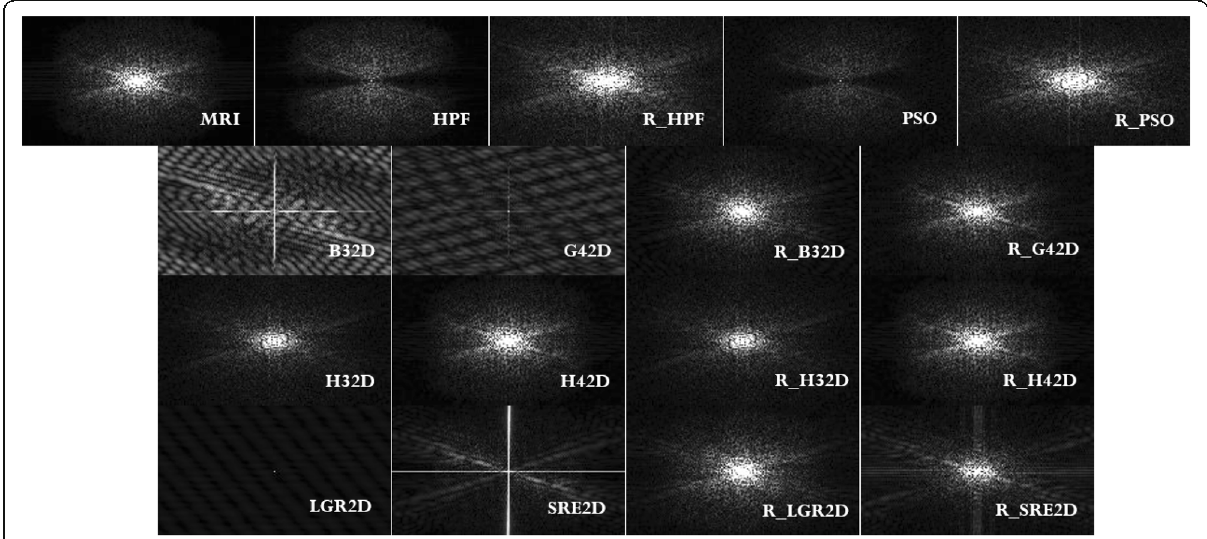
Fig. 9 Comparative study across filtering techniques. The picture shows the respective k-space magnitude of the images displayed in Fig.